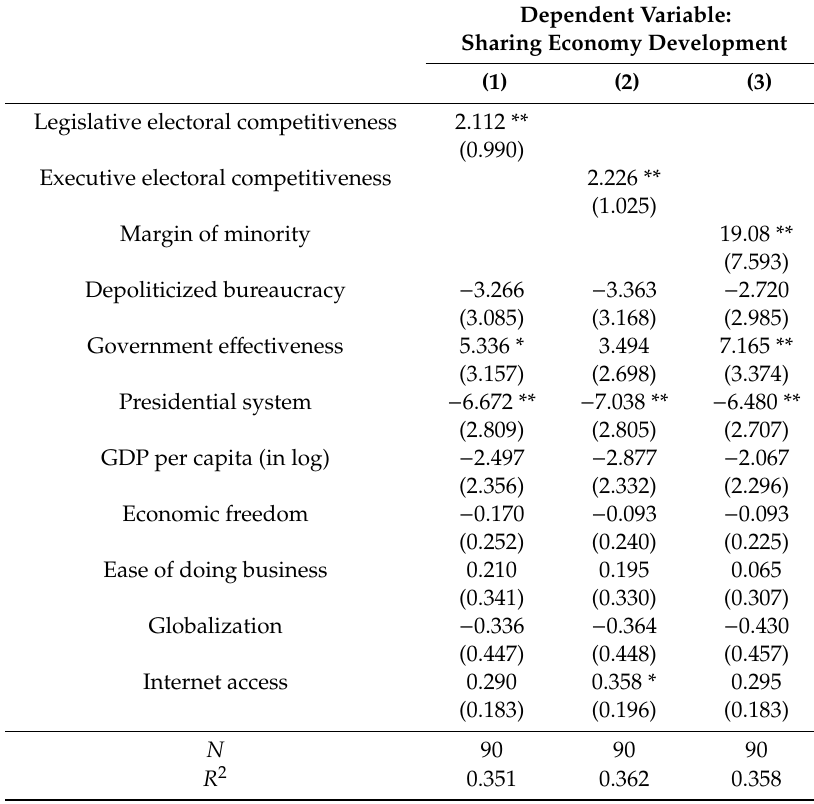
Table 3. Sharing economy development and qualities of government (Hypotheses